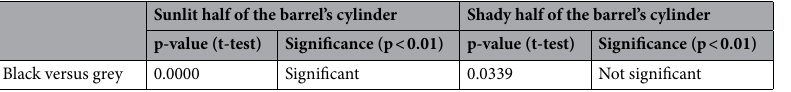
Table 1. Statistical analysis between the relative-area-normalized relative times τ grey / A grey and τ black / A black , where τ grey = t grey /( t grey + t black ) and τ black = t black /( t grey + t black ) are the relative times spent by female tabanids walking on the grey areas ( t grey ) and the black stripes ( t black ) of the sunlit (solar) and shady (antisolar) halves of the barrel’s cylinder in the field experiment, A grey = 93% is the relative area of the half cylinder that was grey, and A black = 7% is the relative area that was covered with thin black